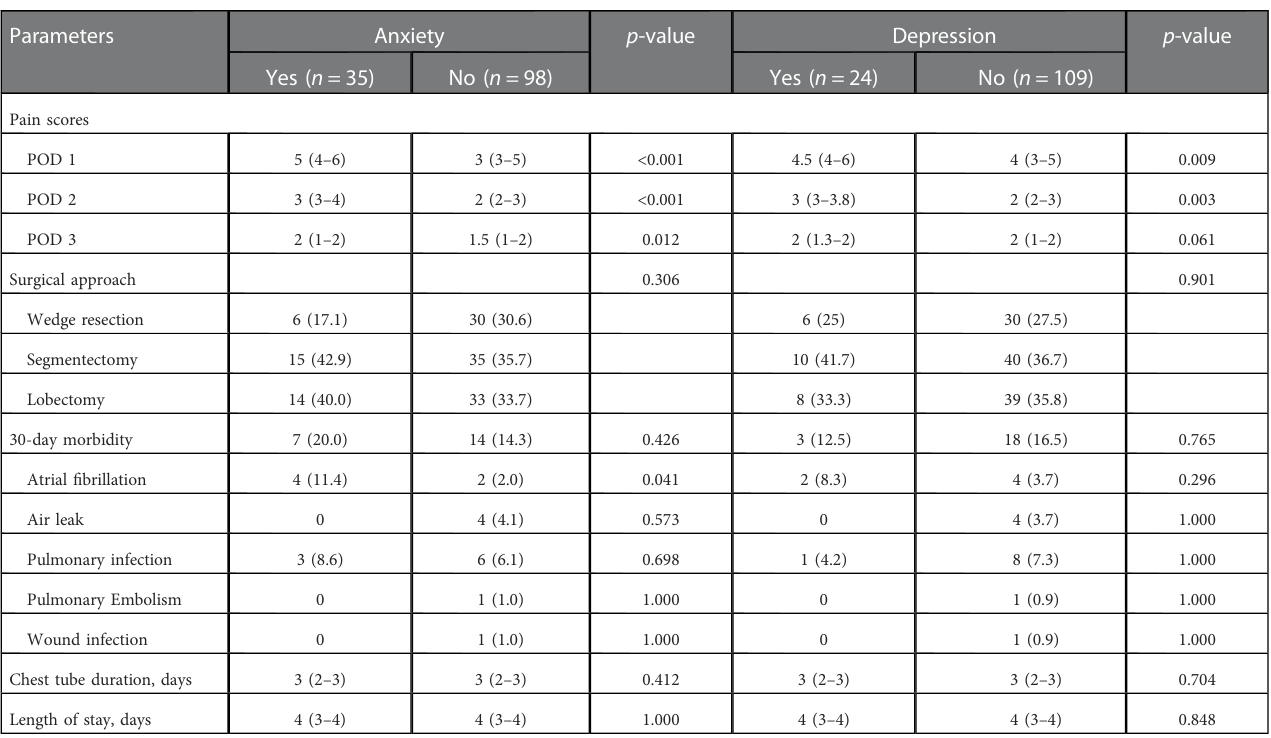
TABLE 6 Effects of anxiety and depression on postoperative